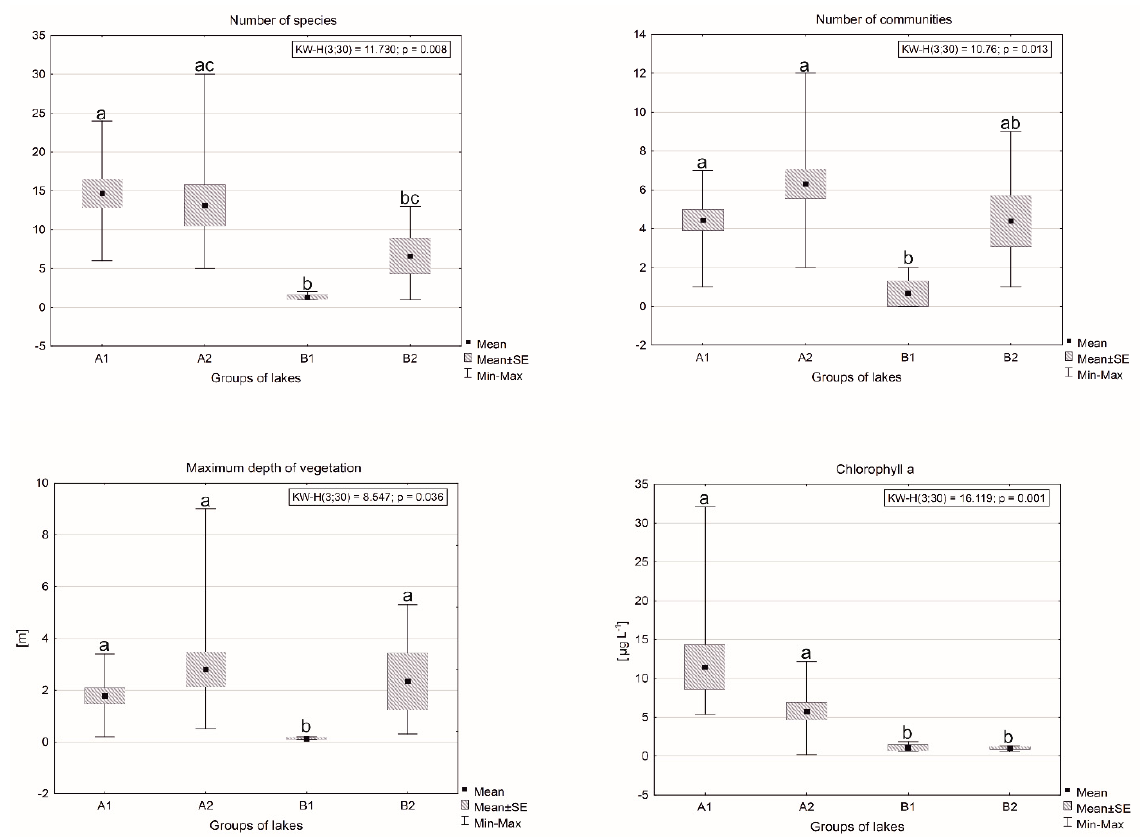
Figure 3. Differentiation of the number of species, number of communities, maximum vegetation range and chlorophyll-a against distinguished groups of lakes. Different letters above the box and whisker plots indicate significant ( p < 0.05) group-to-group differences: the same letters = no differences; different letters = significant differences.